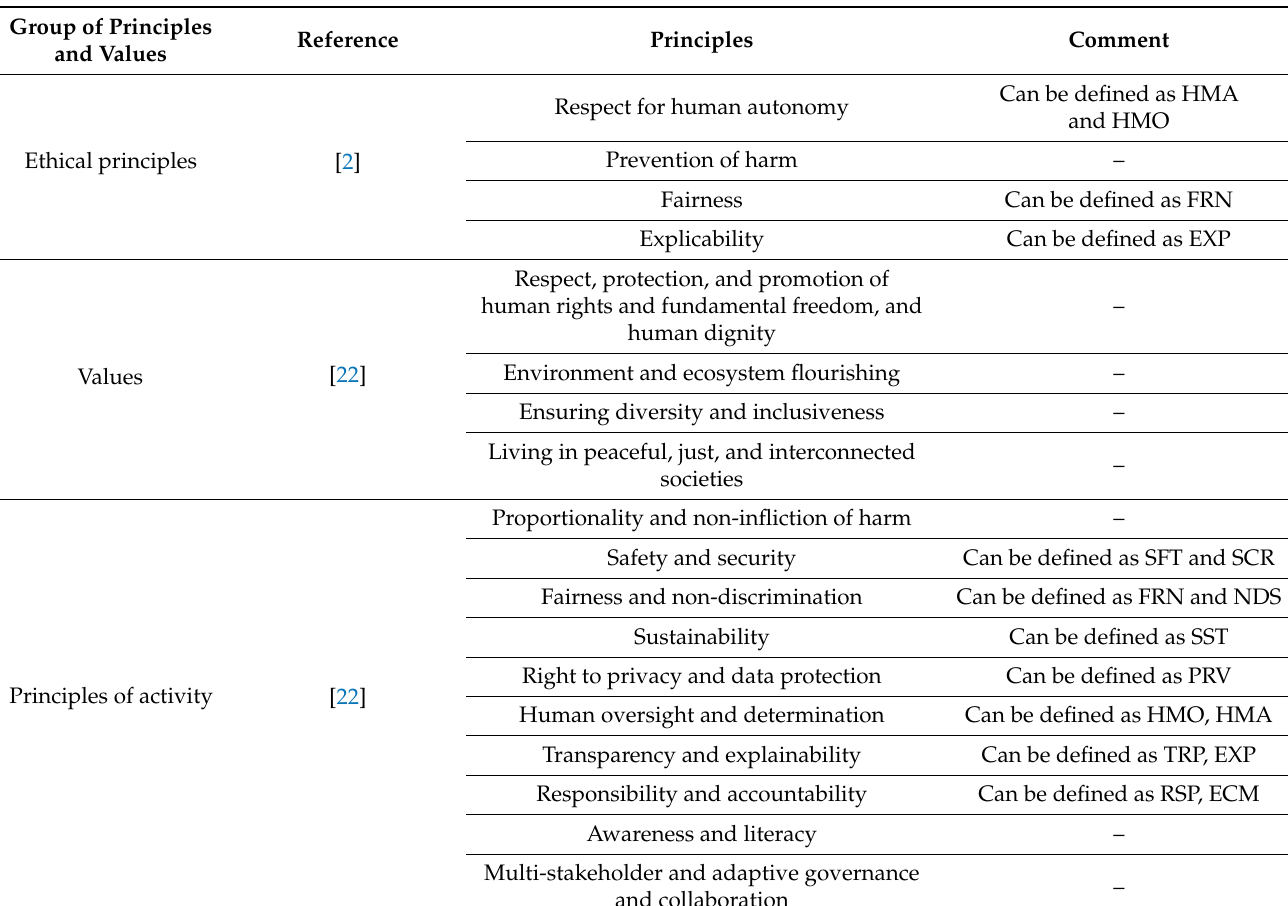
Table 2. Analysis of principles and characteristics of AI and AI systems.